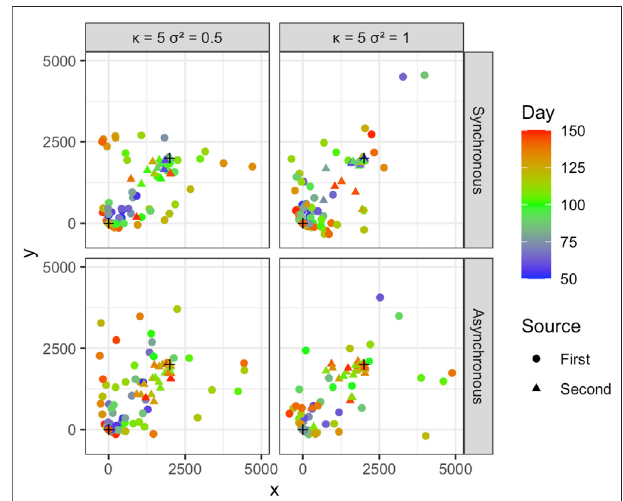
FIGURE 4 | The locations of observations from one simulation for κ (cid:1) 5 and σ 2 (cid:1) 0.5 and 1. The results are shown for temporally synchronous and asynchronousepidemics.The x and y axisscalesaresetto-500and5,000for bettervisualization.Notethat x and y